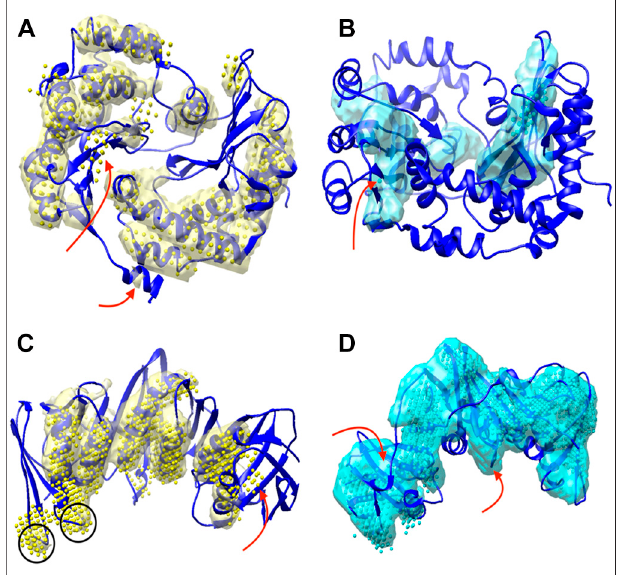
FIGURE 3 | Secondary structures detected using DeepSSETracer 0.1 and Emap2sec+ for two chains. Two views of detected secondary structures in cryo-EM component map (EMD-8129, chain AA of PDB-5j8k (blue ribbon)) are shown for detected helix regions using DeepSSETracer 0.1 (yellow transparent volume) and Emap2sec+ (yellow dots) in (A) and β -sheet regions using DeepSSETracer (cyan transparent volume) and Emaps2sec+ (cyan dots) in (B) . The front view and the back view of the detected secondary structures from cryo-EM component map (EMD-4141, chain B of PDB-5m1s (blueribbon))usingDeepSSETracer0.1(transparentvolume)andEmap2sec+ (dots). Locations of some major differences in the detection are indicated with red arrows. Examples of false positive regions shared by both methods are indicated with black